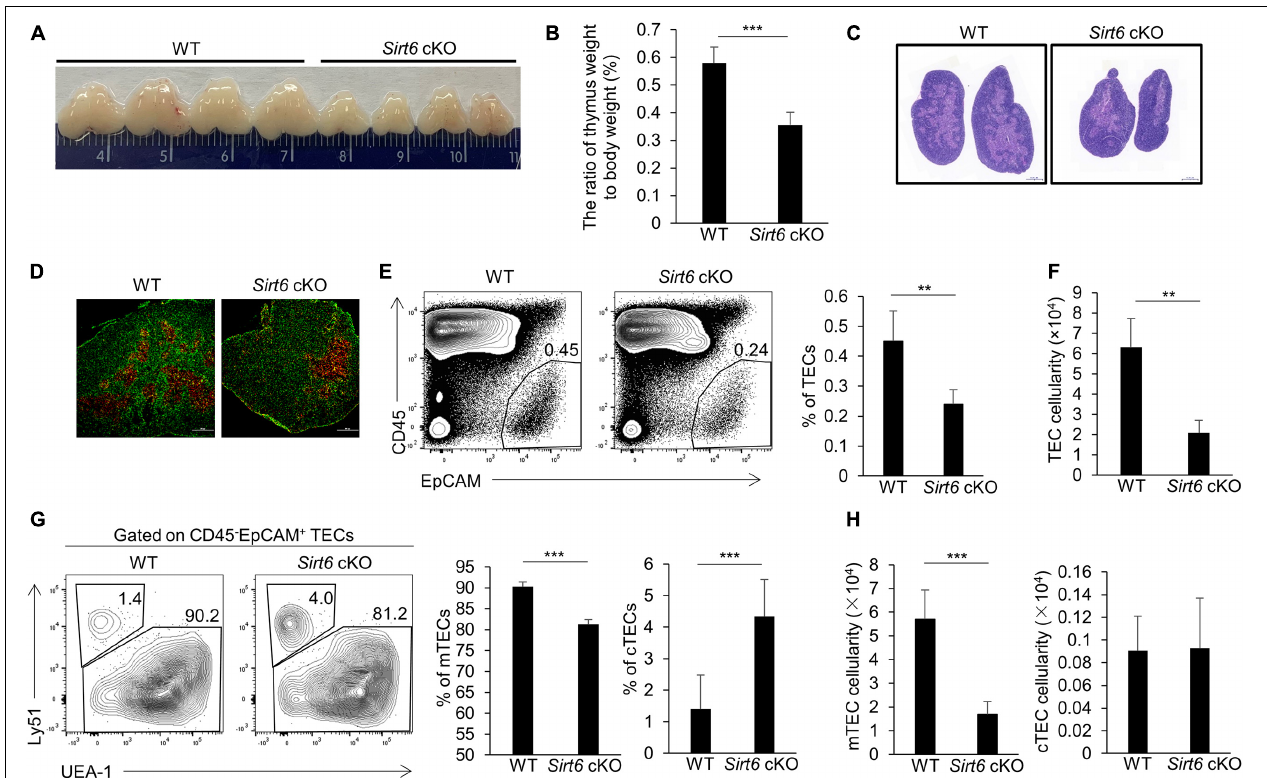
FIGURE 1 | TEC-specific ablation of Sirt6 causes thymus atrophy and reduces mTEC compartment. (A) Representatives of thymi isolated from 4-week-old Sirt6 cKO mice and wild-type littermates. (B) Thymic weight normalized to body weight in 4-week-old wild-type and Sirt6 cKO mice. (C) Hematoxylin and eosin (H&E) stained thymic sections of 4-week-old wild-type and Sirt6 cKO mice. Scale bars: 1,000 µ m. (D) Representative staining of frozen thymic sections of wild-type and Sirt6 cKO mice. KRT8 (green) and KRT5 (red) highlights cortical regions and medullary regions, respectively. Scale bars: 500 µ m. (E) Representative flow cytometric profiles and frequency of CD45 − EpCAM + TECs obtained from 4-week-old Sirt6 cKO mice and littermates. (F) Total cell numbers of TECs of 4-week-old Sirt6 cKO mice and littermates. (G) Representative flow cytometric profiles showing frequencies of mTECs (UEA-1 + Ly51 − ) and cTECs (UEA-1 − Ly51 + ) were first gated on TECs. (H) Total cell numbers of mTECs (left) and cTECs (right) of 4-week-old wild-type and Sirt6 cKO mice. N = 4 per group. ** p < 0.01 and *** p < 0.001 (Student’s t